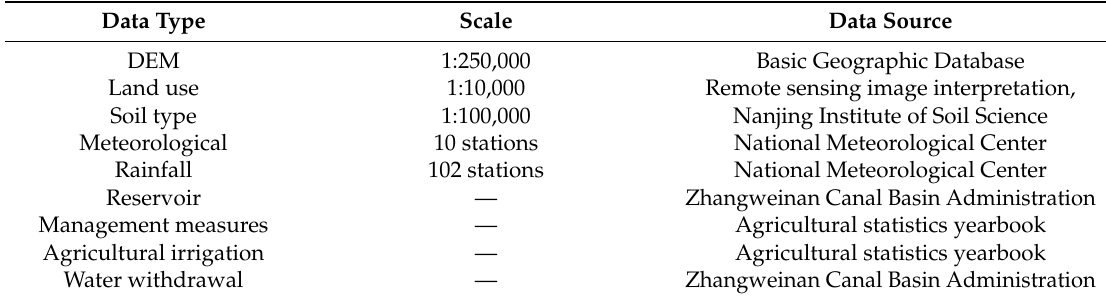
Table 1. Data items and data sources of the SWAT